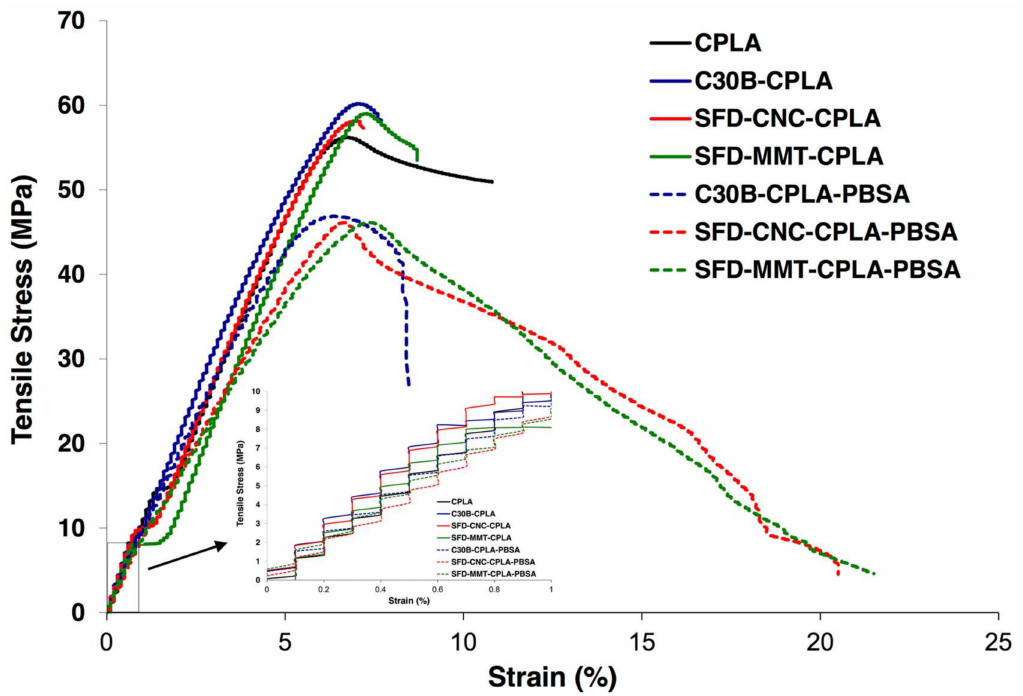
Figure 12. Stress–strain curve of the PLA nanocomposites and PLA-PBSA ternary